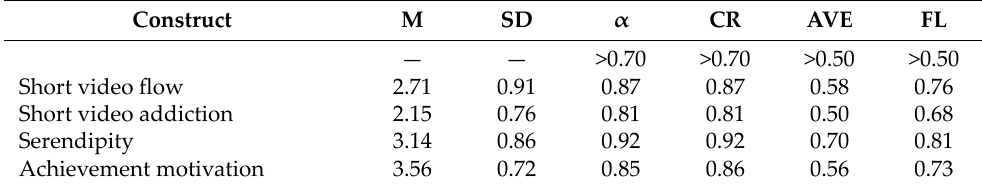
Table 2. Reliability and Validity Analysis.